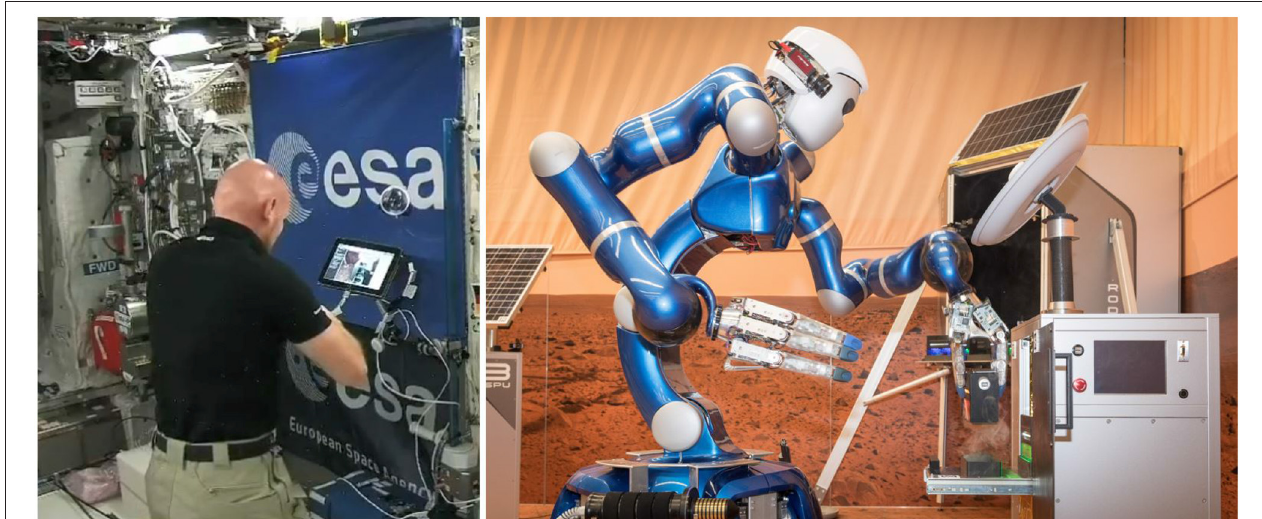
FIGURE 8 | ESA astronaut Alexander Gerst on board the ISS ( left , credit: ESA) commanding DLR’s Rollin’ Justin in the SOLEX environment to perform component retrieval and assembly tasks (right) .